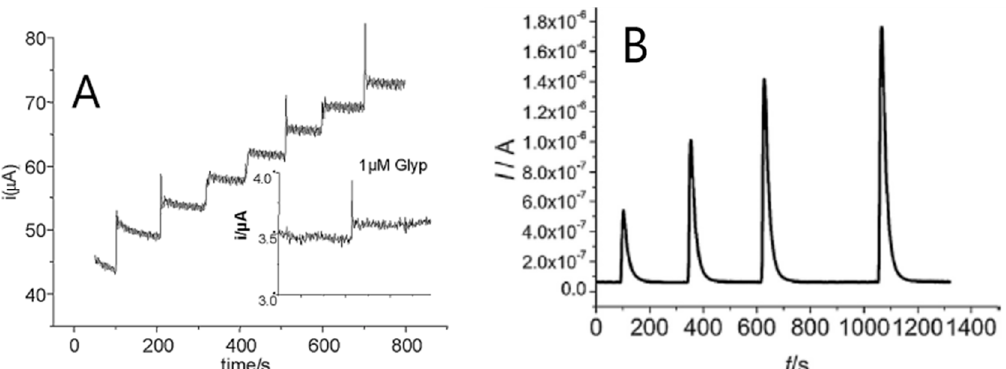
Figure 6. Examples of I vs. t curve obtained ( A ): at a Ni/Al LDH coated Pt electrode in batch for seven successive additions of 0.125 mM Glyp, inset shows the LOD of Glyp (E appl = +0.49 V vs. SCE) in 0.1 M NaOH; ( B ): at a Co/Al LDH coated Pt electrode in FIA, by injecting fructose solutions at different concentrations (1.0 × 10 − 4 , 2.0 × 10 − 4 , 3.0 × 10 − 4 and 4.0 × 10 − 4 M). Eluent: 0.01 M NaOH containing 0.1 M KNO 3 , flow rate: 1 mL min − 1 ; E app : + 0.50 V vs. Ag/AgCl. Images reproduced from [59,60] with permission.